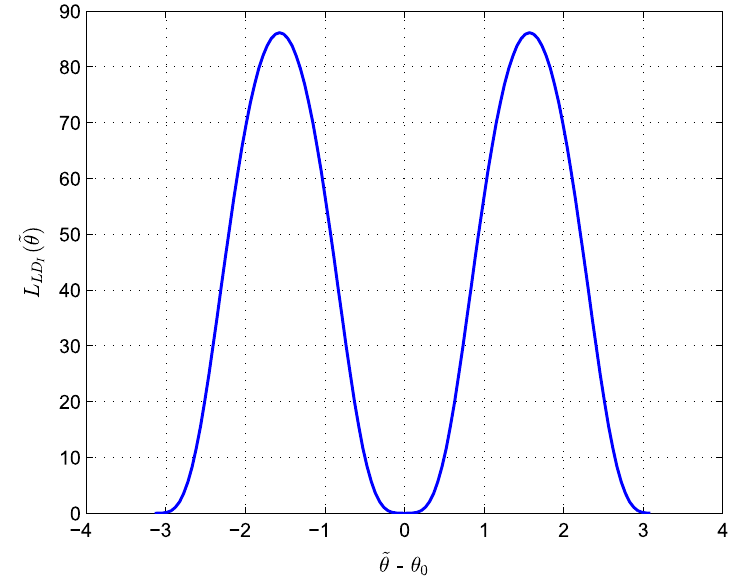
Fig. 2 L LD I ( ˜ θ) curve versus the phase offset estimation error ˜ θ − θ 0 in a noise-free